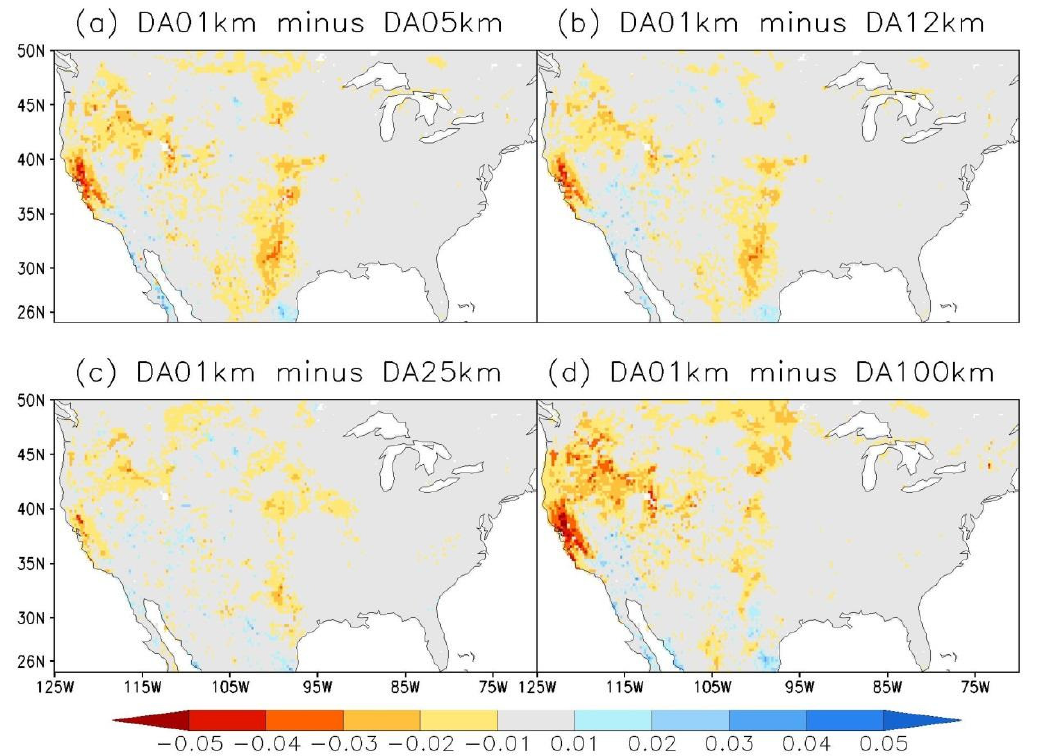
Figure 2. Differences in CTR run-based root mean square differences (RMSDs) for 40–100 cm soil moisture (SM) simulations during 2015 to 2018 period: ( a ) DA01km Minus DA05km, ( b ) DA01km Minus DA12km, ( c ) DA01km Minus DA25km, and ( d ) DA01km Minus DA100km. The red (blue) color indicates DA01km case performs better (worse), while grey color means insignificant.